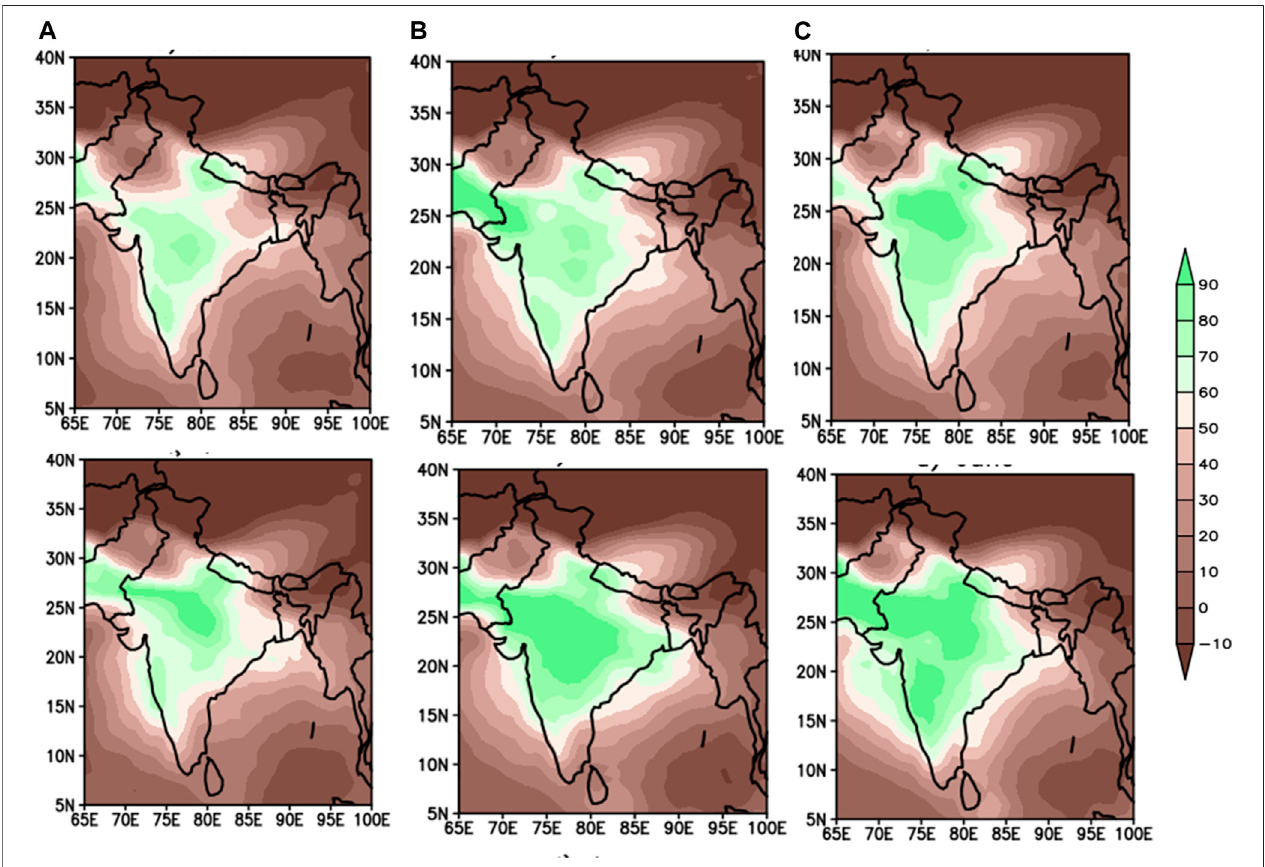
FIGURE 3 | Anomalies in ART for June over India for the periods (A) 2016 – 2035, (B) 2046 – 2065 and (C) 2080 – 2099 under RCP 4.5 (top panel) and 8.5 (bottom panel) emission scenarios.